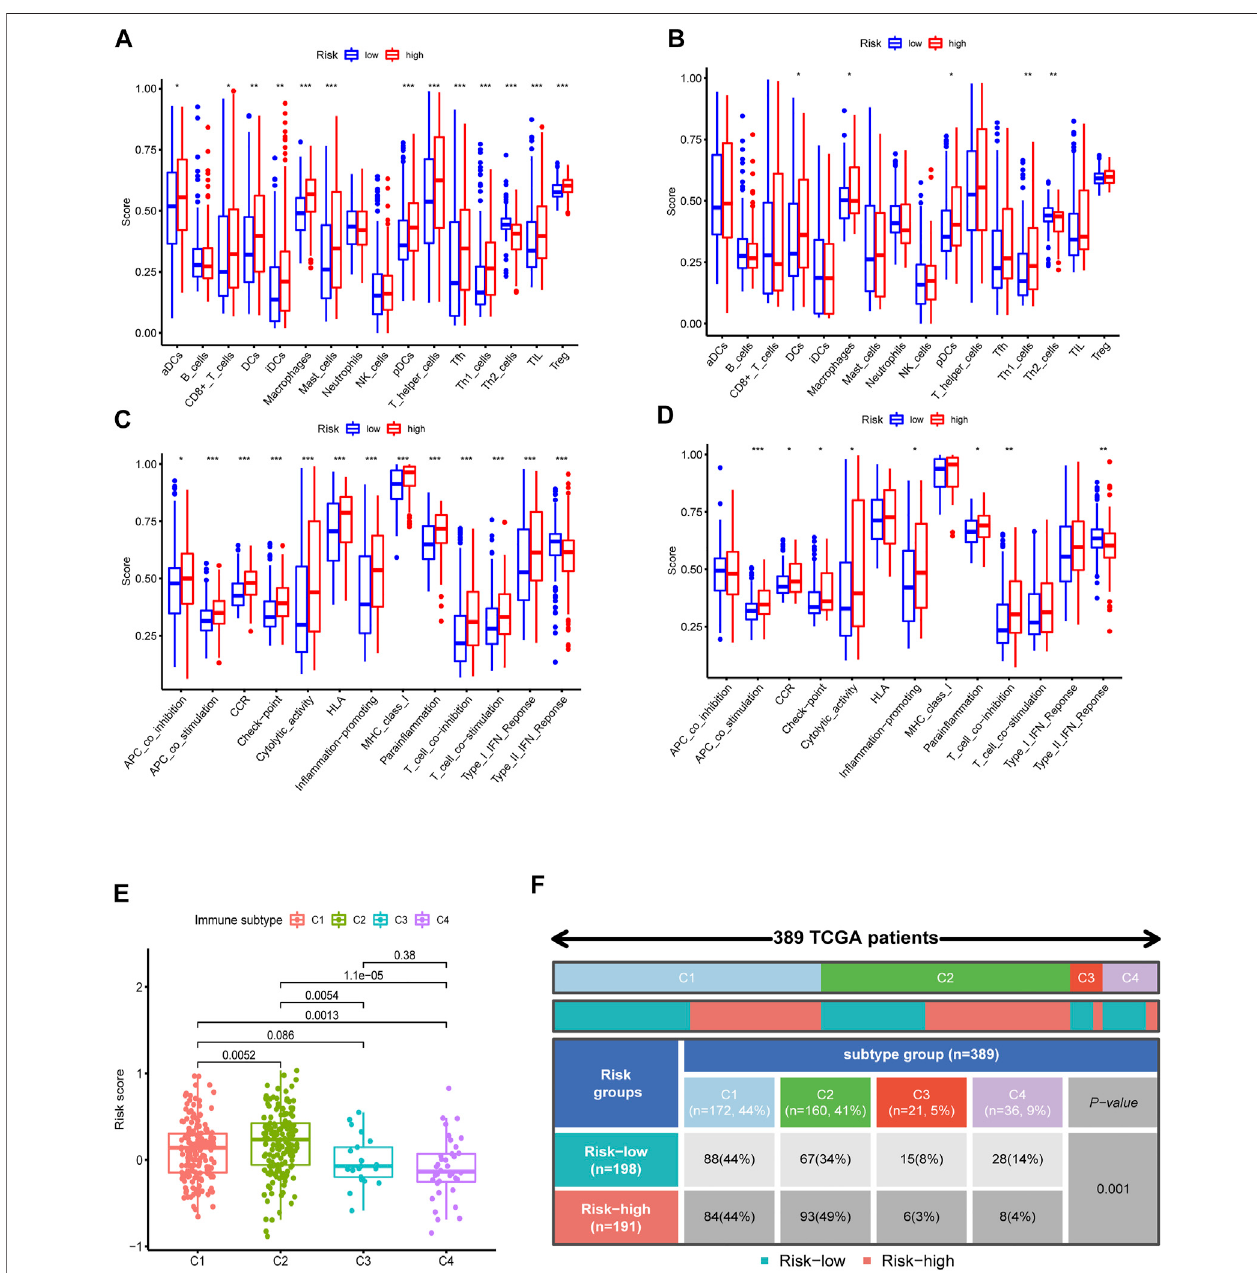
FIGURE 7 | Immune feature analysis and immune subtype classi fi cation. Comparison of immune cells (A , TCGA; B , GSE32894 ) and immunologic function (C , TCGA; D , GSE32894 ) between the high- and low-risk groups. (E,F) Immunologic subtypes correlated with risk scores.